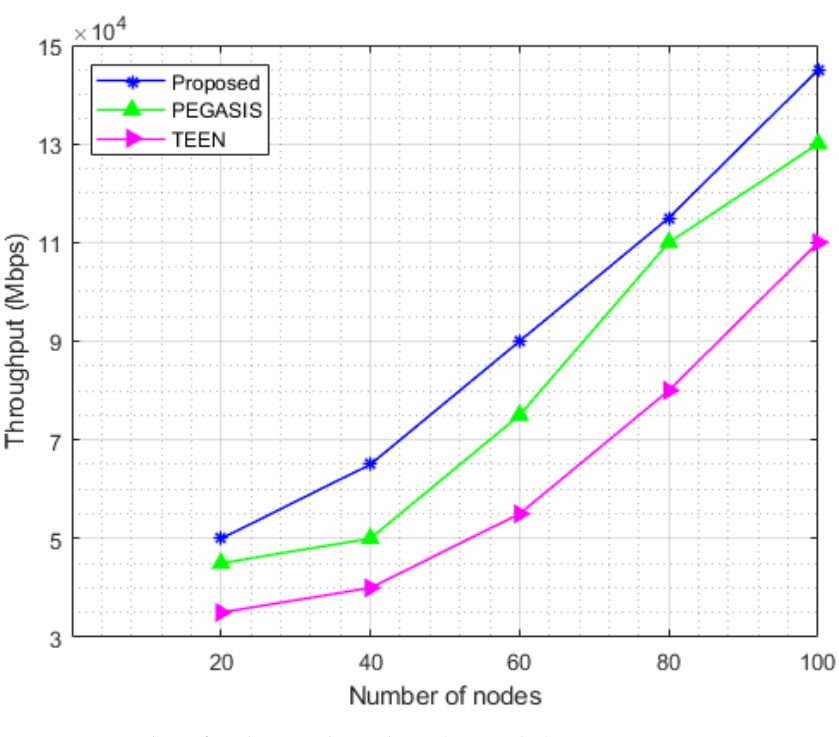
Figure 16. Number of nodes vs. Throughput (100 nodes).